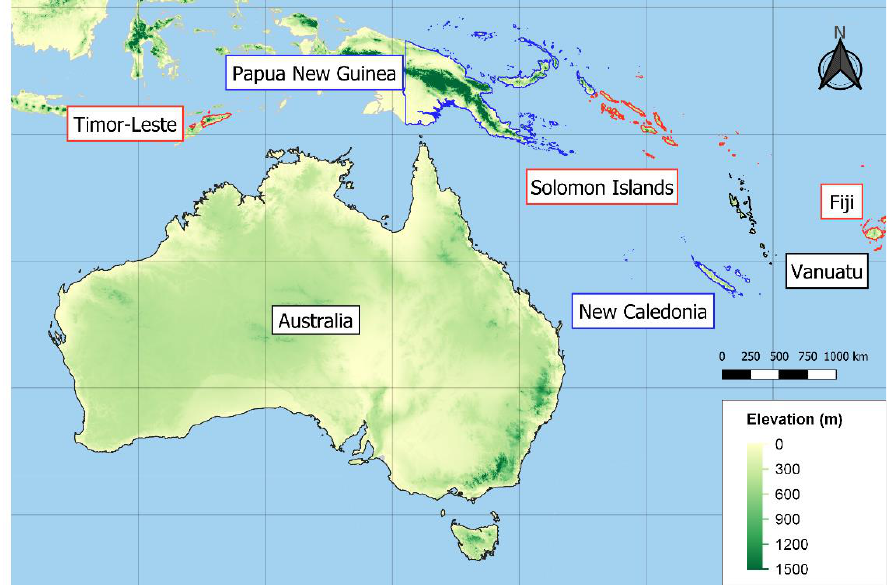
Figure 2. TC Analysis domain with the six-country sub-domains of Australia, Timor-Leste, Papua New Guinea, Solomon Islands, New Caledonia, Fiji, and Vanuatu pictured.